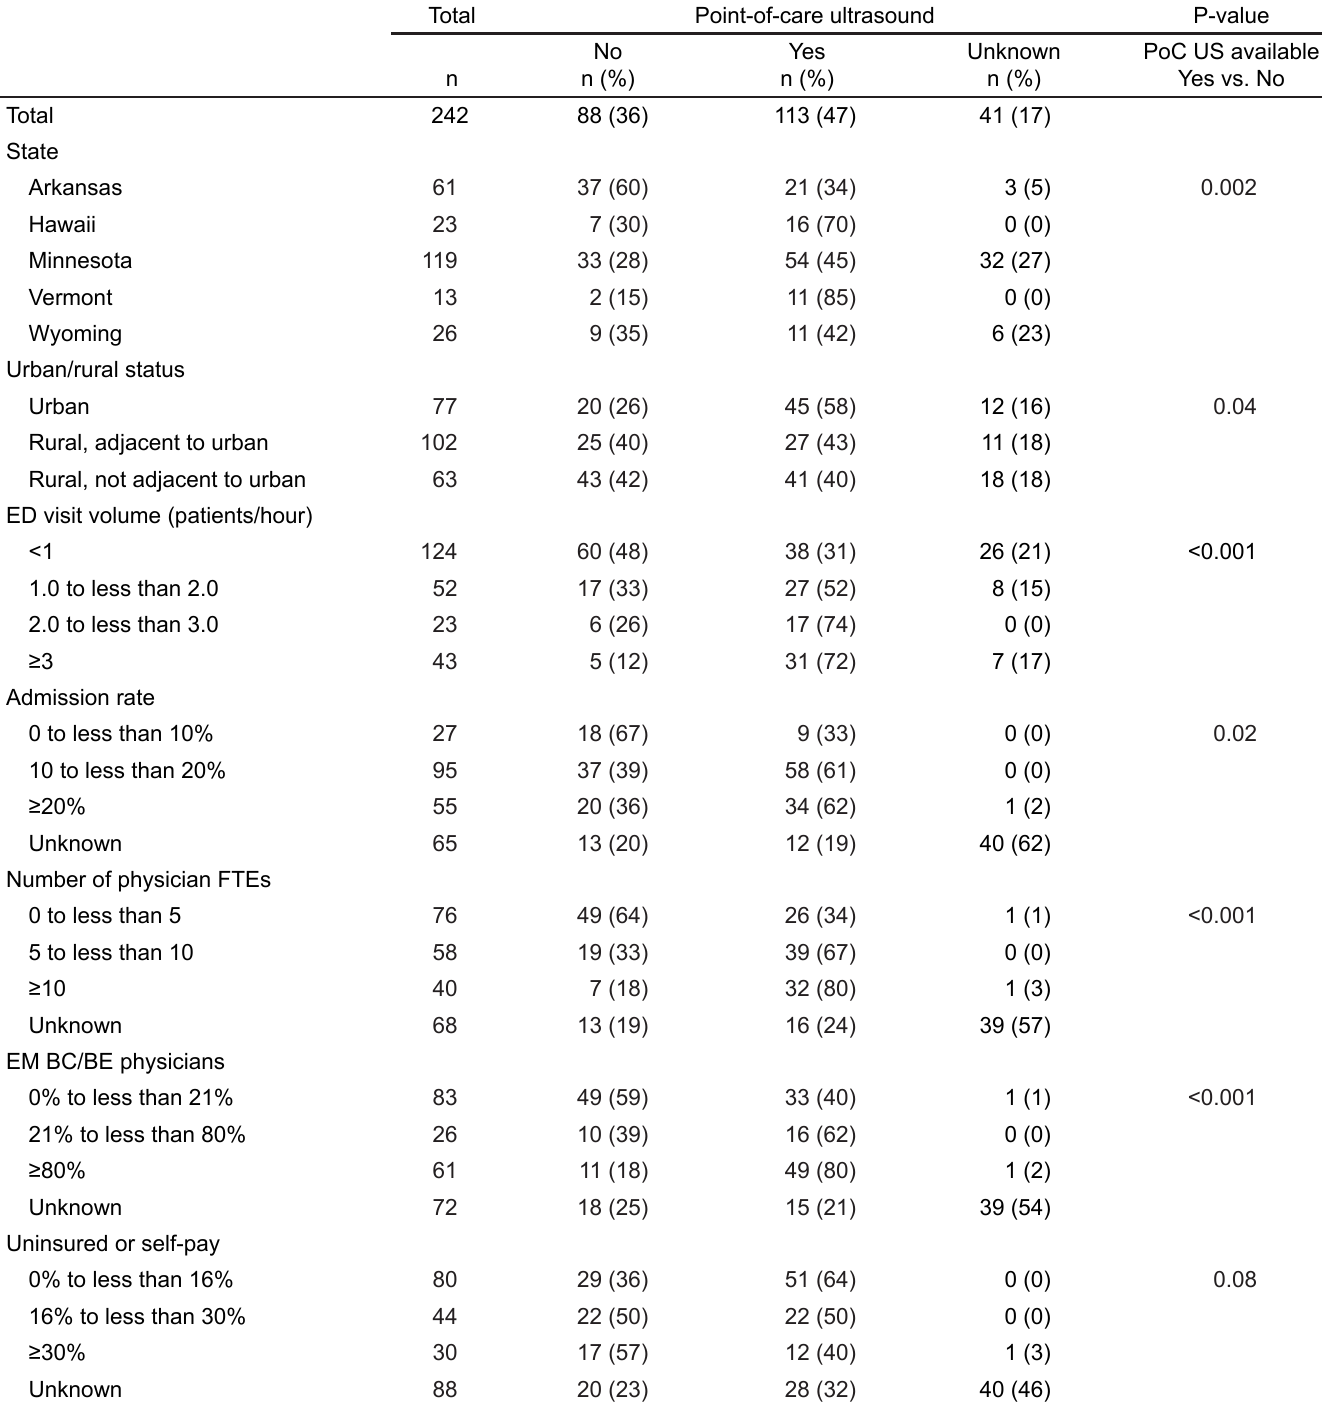
Table 1. Availability of point-of-care ultrasound in five states (n=242 emergency